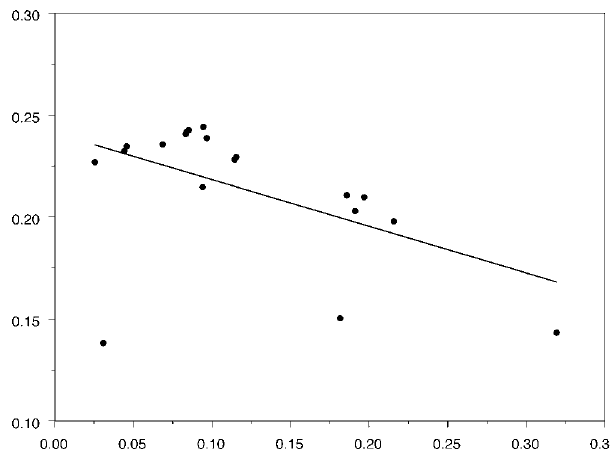
Figure 4. Selection Differential on Birthweight (S) against Estimated Total Heritability ( h 2 T ) Each point represents the values measured in 1 y. The solid line shows the least-squares linear regression of estimated total heritability ( h 2 T ) on selection differential (S). The strength and direction of this relationship is unchanged by removal of outliers in the lower portion of the graph. DOI: